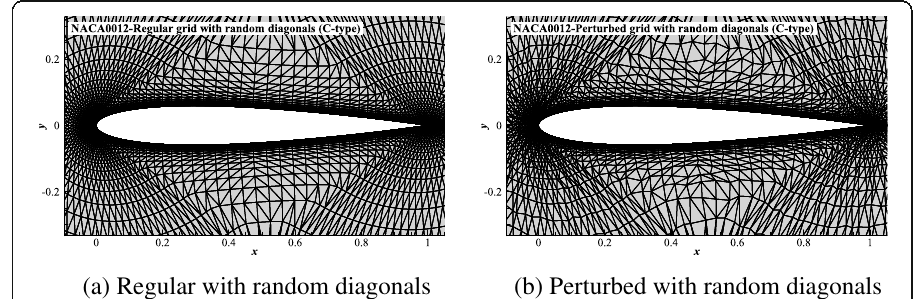
Fig. 24 ( a ) Regular and ( b ) randomly perturbed triangular grids with C -type over a NACA0012